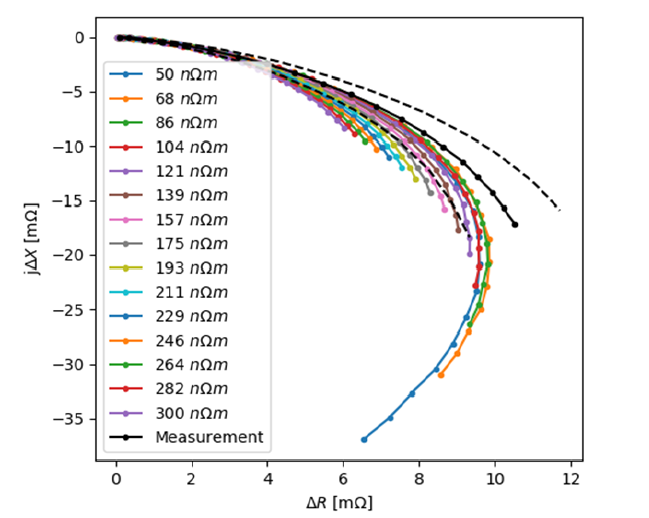
Figure 16. Coil response for HIPIMS Mo coating on graphite. The measurements are shown with black lines together with standard deviation (dashed lines) and the simulated response for coating resistivity between 50 n Ω m and 300 n Ω m. The coating has a thickness of 6 µ m, the bulk of 1.5 mm. The lift-off is 0.7 mm.